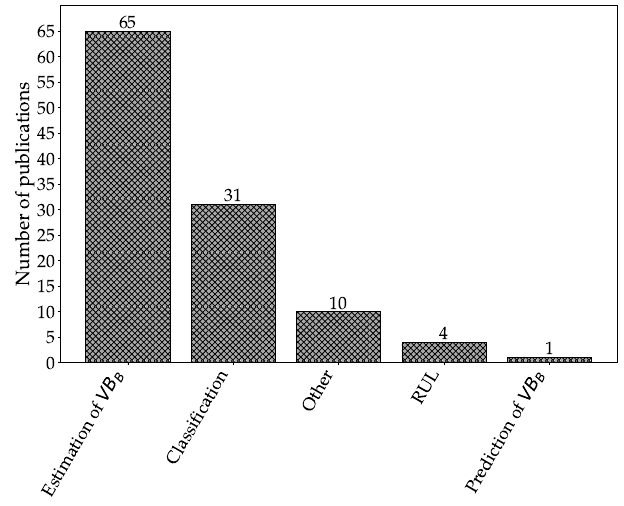
Figure 21. Output variables of all the approaches.